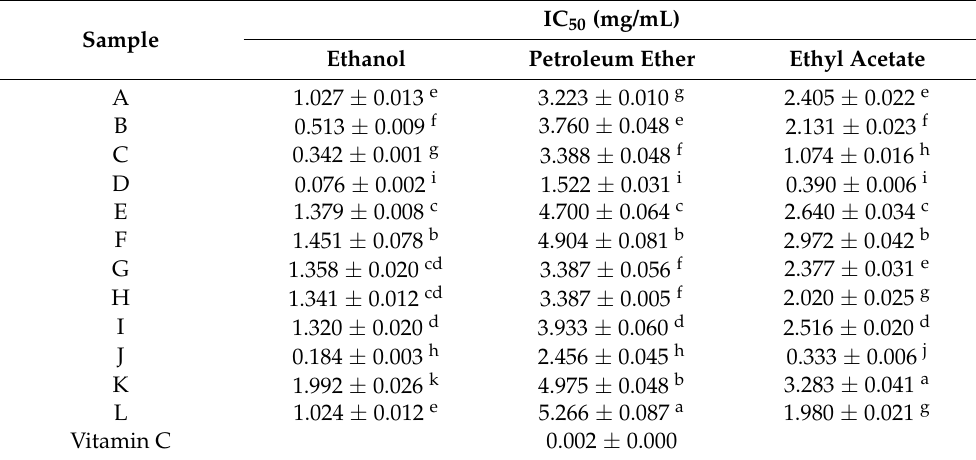
Figure 7. Transmittance spectra of the ethyl acetate extractives from Alnus cremastogyne pods. Table 6. Radical scavenging capacity of DPPH of ethanol, petroleum ether, and ethyl acetate extrac- tives from Alnus cremastogyne